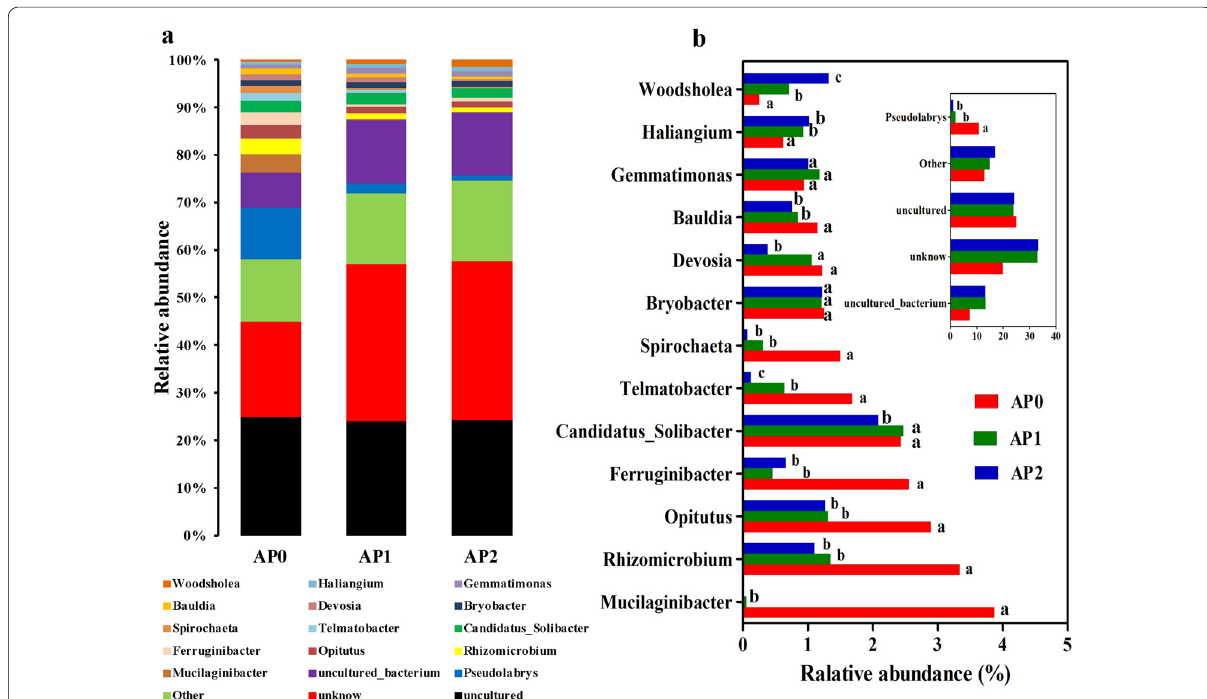
Fig. 5 Relative abundance of the dominant bacterial genus in the soils continuously cropped Andrographis paniculata. a Bacterial community composition at the genus level. b Variations of bacterial community composition. Only genera with more than 1% relative abundance in at least one sample were shown and different letters mark significant difference at P < 0.05. The “Other” group contained the genera with relative abundance < 1%. AP0, AP1 and AP2 represent soils with continuously cropping histories of A. paniculata for 0, 1 and 2 years